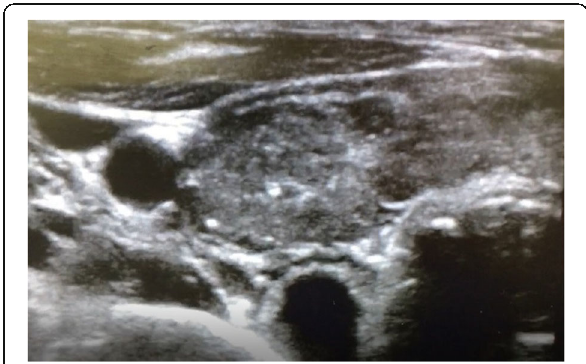
Fig. 2 Ultrasonography of the thyroid. The left lobe is heterogeneously enlarged with hypoechoic areas and calcifications